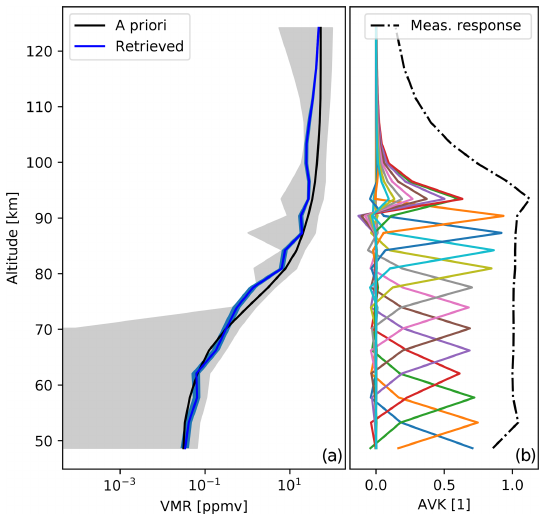
Figure 5. Example retrieval referring to ScanID 1579335172 from FM22. (a) Retrieved concentration profile and error (in blue) and a priori including uncertainties (in grey). (b) Averaging kernels plot- ted in a different colour for each altitude (not indicated) and mea- surement